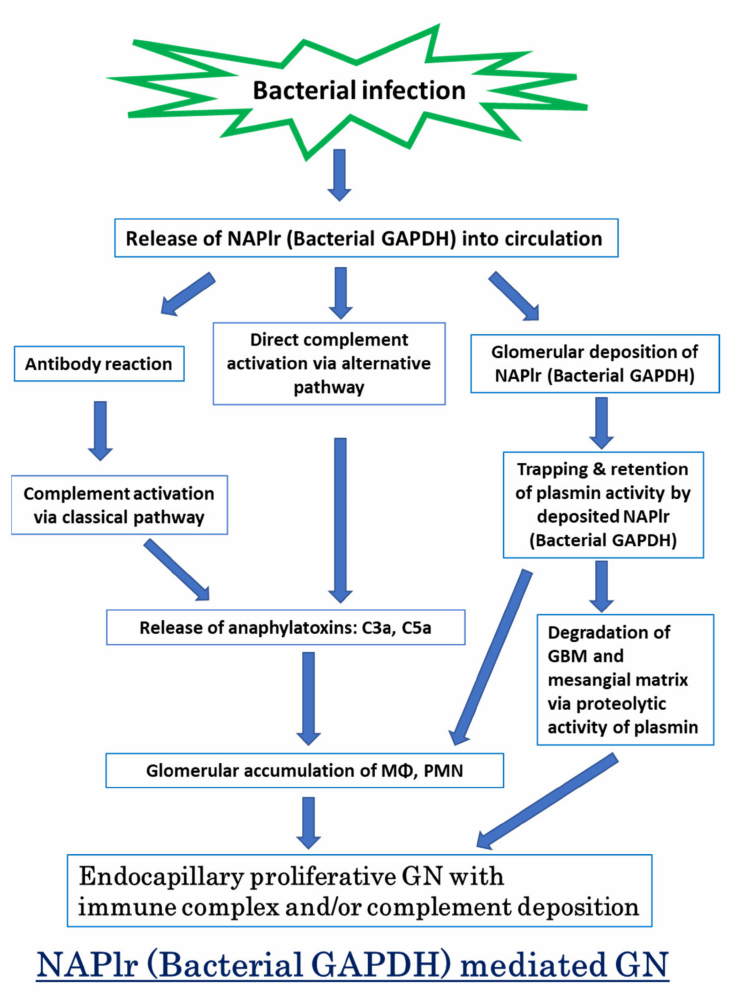
Figure 1. Graphical abstract of this review. NAPlr: nephritis-associated plasmin receptor, GAPDH: glyceraldehyde-3-phosphate dehydrogenase, M Φ : macrophage, PMN: polymorphonuclear neu- trophil, GBM: glomerular basement membrane, GN: